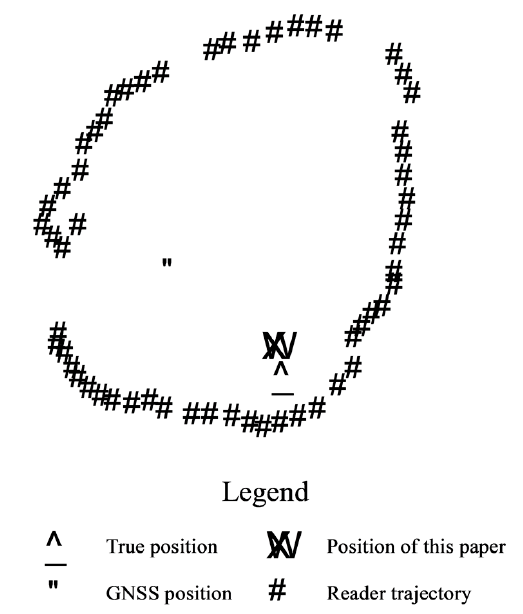
Figure 5. RFID reader moving trajectory of one